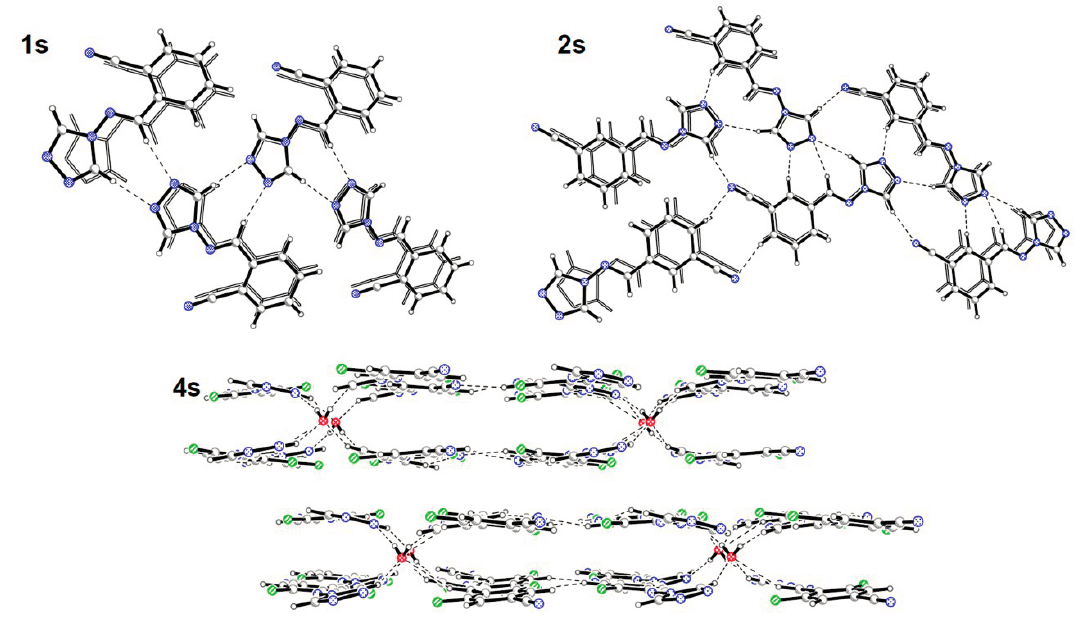
Figure 8. Structural motives in the crystals of imines 1s , 2s and 4s